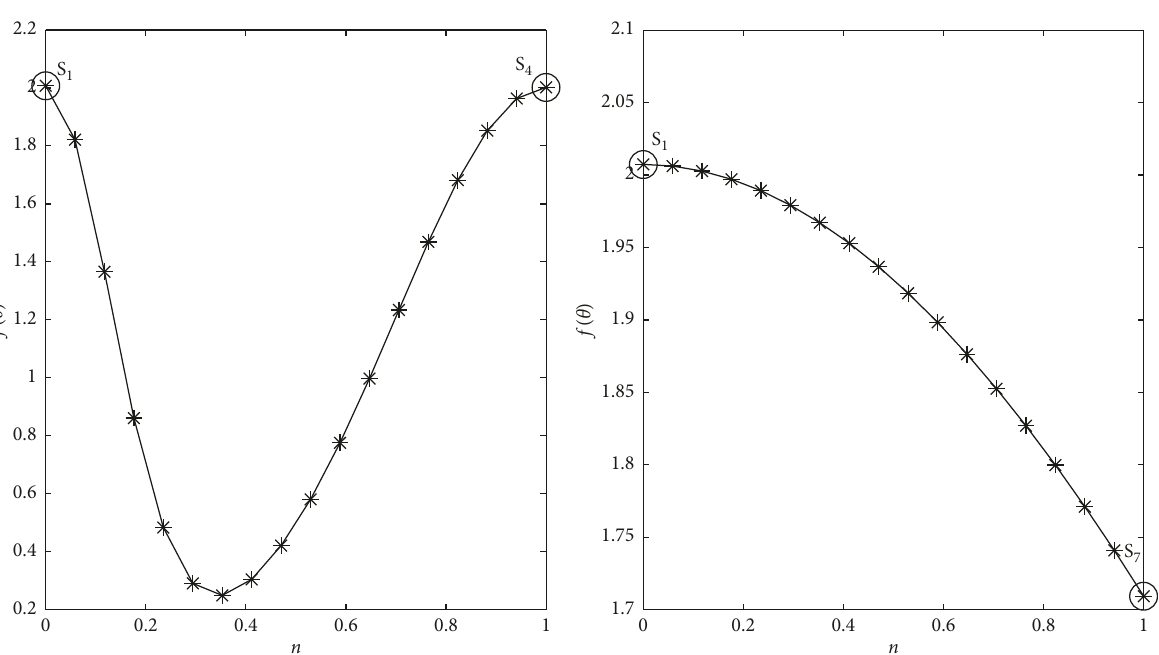
Figure 7: Cut between optima 1 and 4 (left) and optima 1 and 7